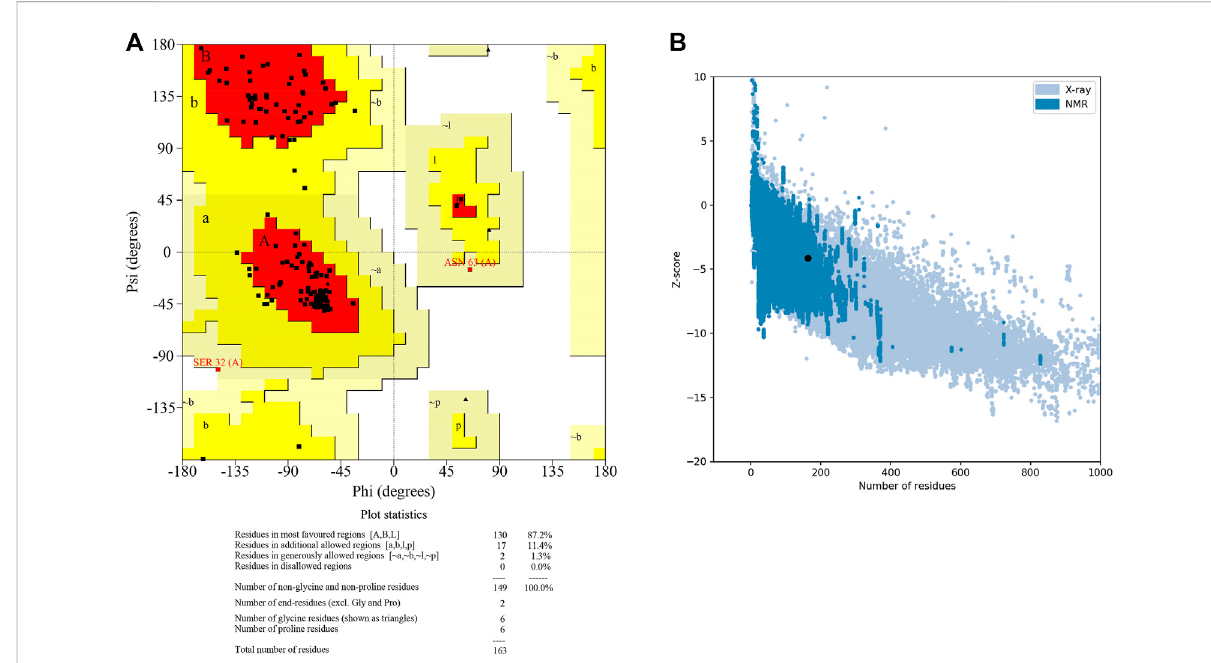
FIGURE 4 Figure showing the (A) Ramachandran plot and (B) Z score plot of domain 3 of